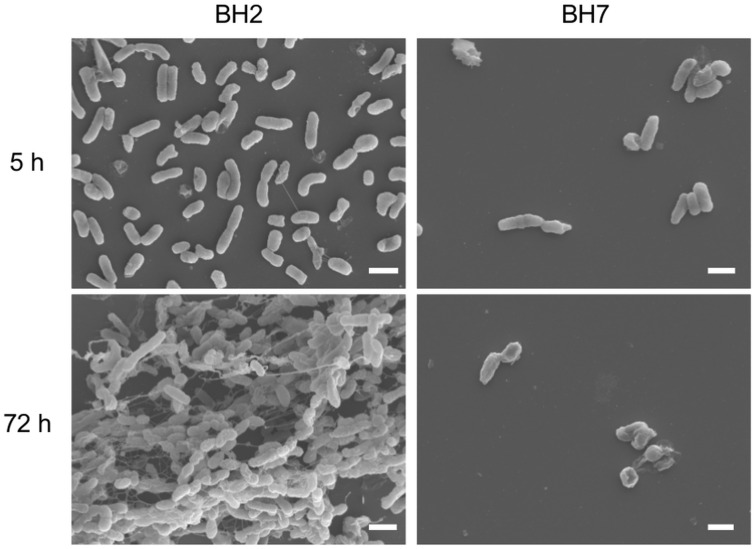
Lack of biofilm formation by Bordetella holmesii isolate BH7.The clinical isolates BH2 and BH7 were cultured statically on vertically submerged glass slides in mSS broth. After 5 and 72 h, the cell adherence and the biofilm growth at the air-liquid interface were visualized by SEM. Scale bars, 1 μm